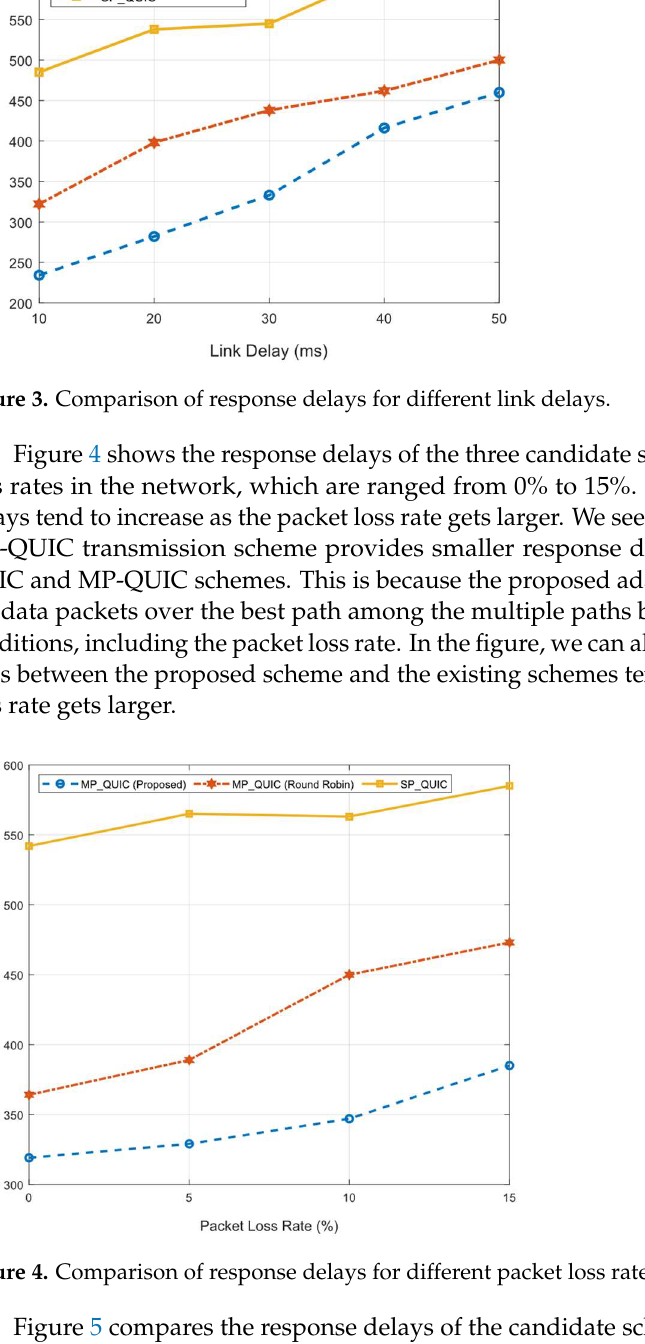
Figure 4. Comparison of response delays for different packet loss rates.